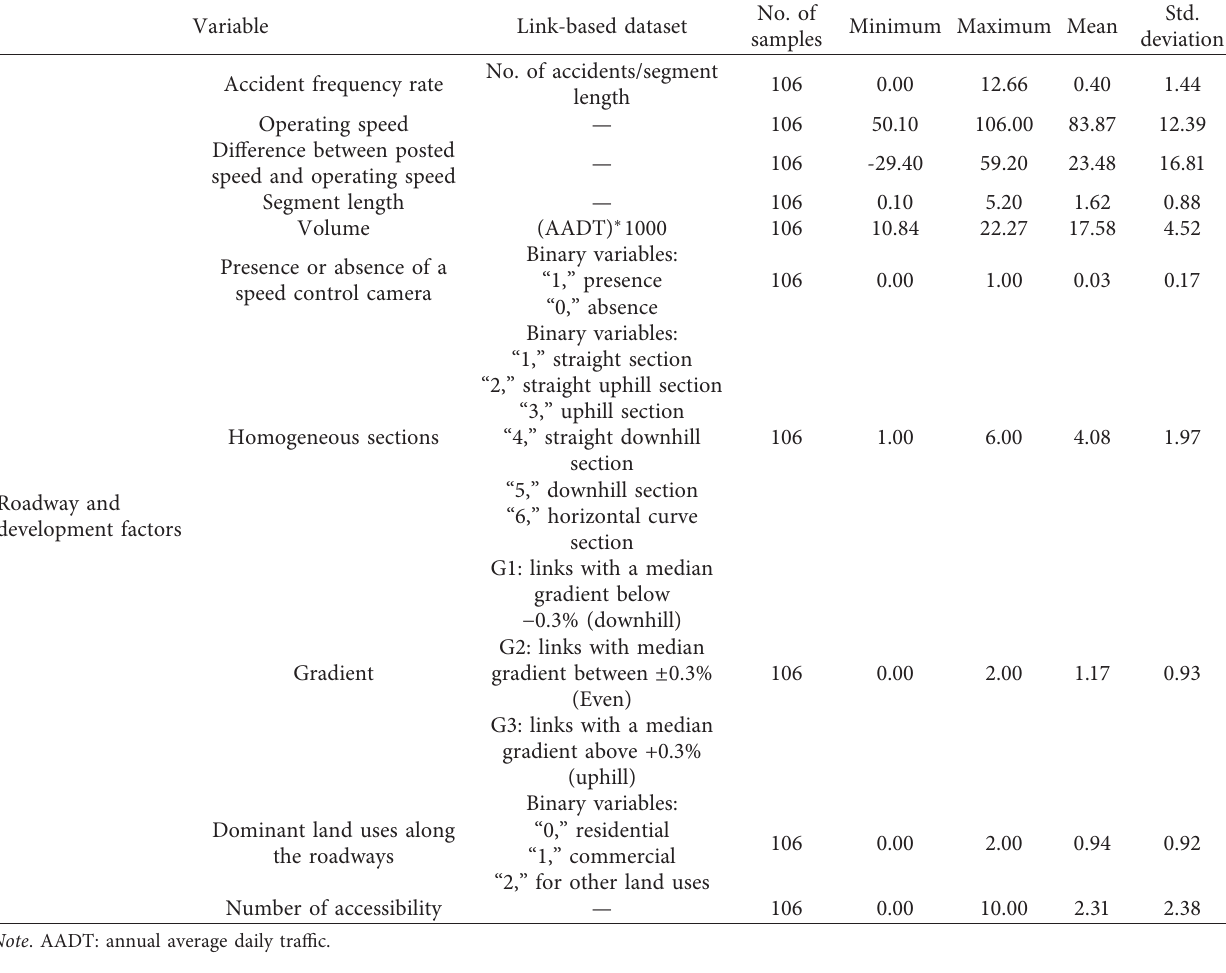
Table 1: Definition of variables included in the link-based dataset and descriptive statistics analysis.